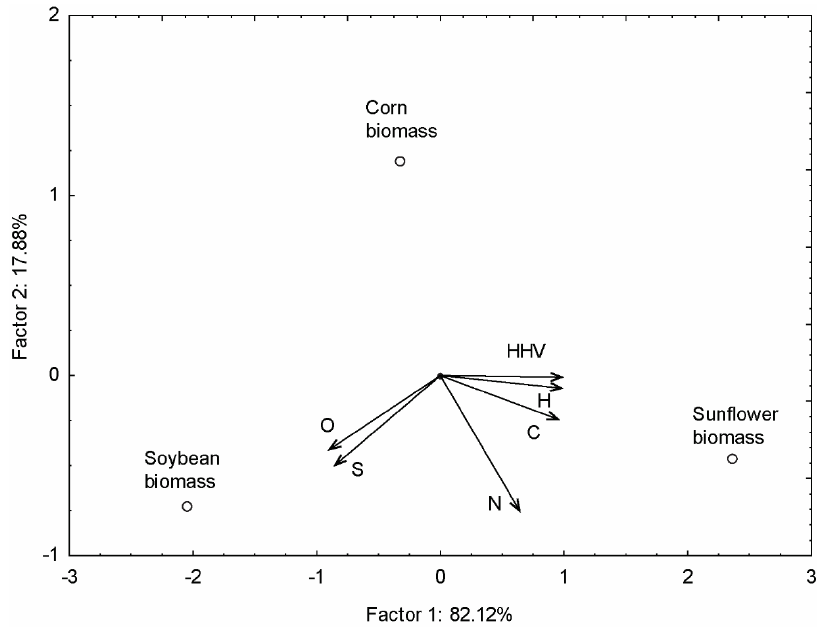
Figure 2. Principal component analysis (PCA) of observed corn, soybean and sunflower biomass.